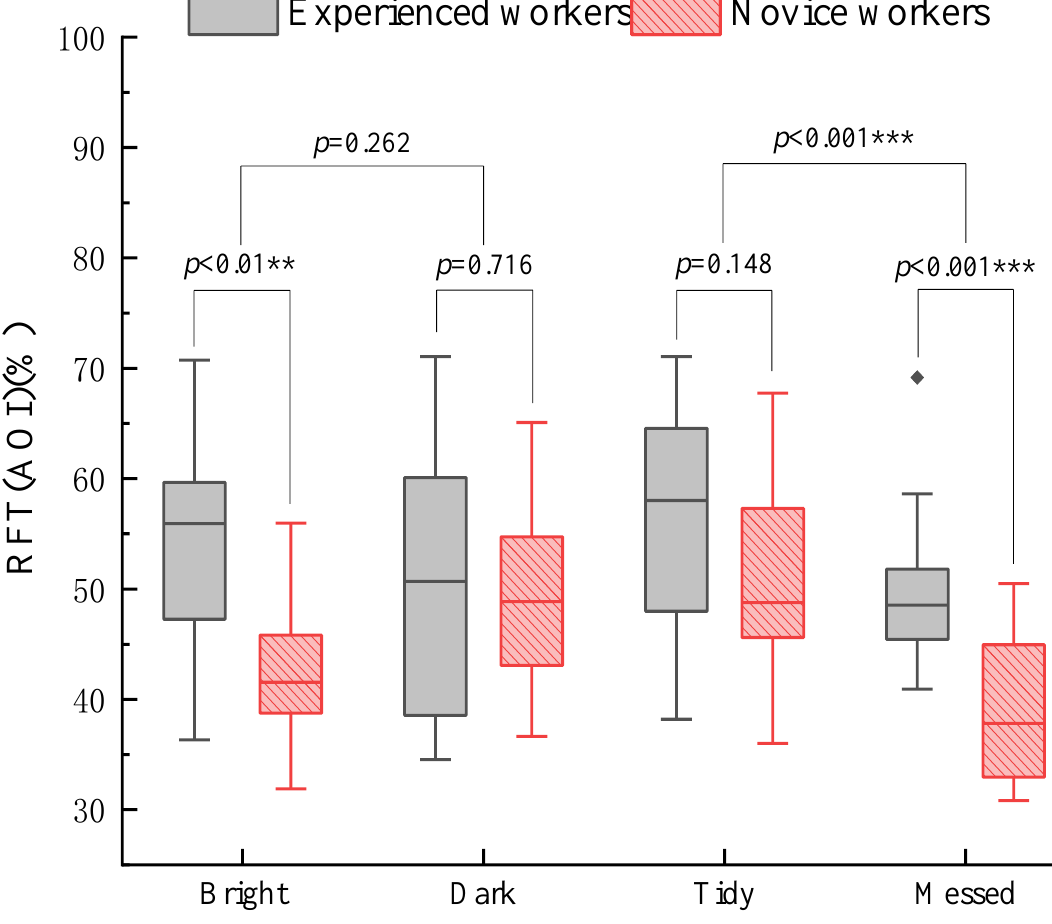
Figure 6. RFT(AOI) for experts and novices in construction sites with various environmental condi- tions. (** and *** indicate significant differences at the 0.01 and 0.001 levels, respectively.)